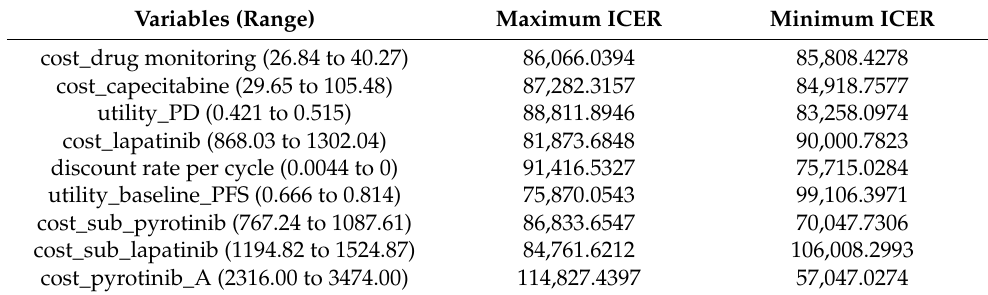
Table A2. The maximum and minimum input values of one-way sensitivity analysis between pyrotinib-A plus capecitabine and lapatinib plus